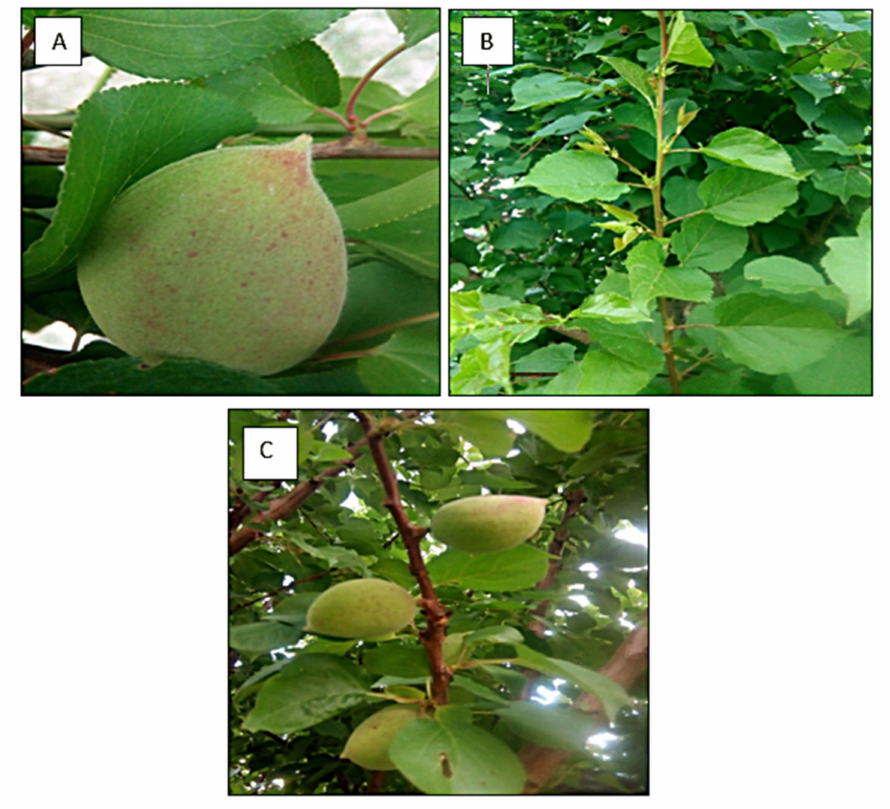
Figure 1. Prunus aitchisonii ( A ) fruit, ( B ) leaves, ( C ) fruits, leaves and